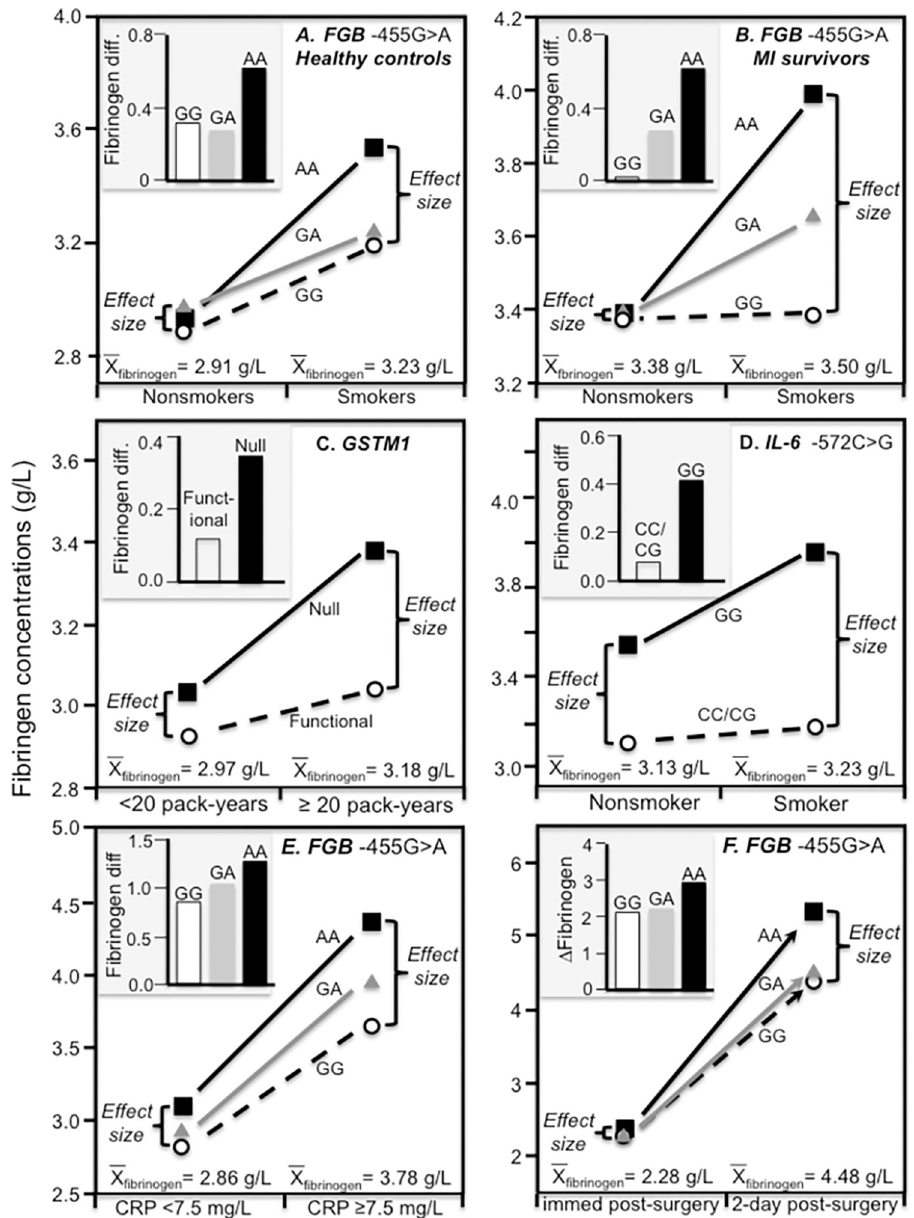
Fig 3. Precision medicine perspective of genotype-specific fibrinogen differences (histogram inserts) vs. quantile- dependent expressivity perspective (line graphs showing larger genetic effect size when average fibrinogen concentrations were high) for: (A) Scarabin et al.’s 1993 report [50] on the smokers-nonsmoker difference by the − 455G > A polymorphism of the fibrinogen beta chain ( FGB ) promoter region in healthy controls; (B) Scarabin et al.’s 1993 report [50] on the aforementioned smokers-nonsmoker difference in myocardial infarction survivors; (C) Miller et al.’s 2003 report [51] on the difference between more vs. less pack-years of smoking by the glutathione-s-transferases (GTS) M1 polymorphism; (D) Shin et al.’s 2007 report [52] on the smokers-nonsmoker difference by the interleukin-6 ( IL6 ) -572C > G polymorphism; (E) Gardemann et. al.’s 1997 report [55] on the difference between patients with clinical signs of an acute phase reaction (i.e., CRP � 50 th percentile) than without by FGB − 455G > A polymorphism; (F) Gardemann et. al.’s 1997 report [55] on the fibrinogen increase 2-days after aortacoronary bypass surgery by the FGB − 455G > A polymorphism.